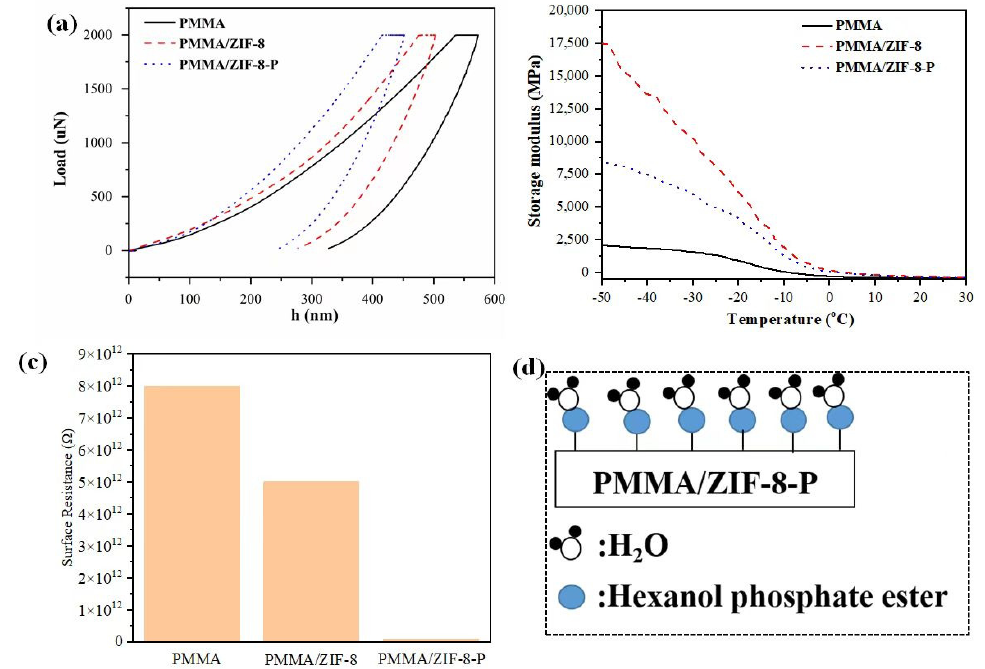
Figure 2. ( a ) The curves for load–displacement of the PMMA, PMMA/ZIF-8 and PMMA/ZIF-8-P composites. ( b ) Storage modulus gained from the DMA analysis of PMMA, PMMA/ZIF-8 and PMMA/ZIF-8-P composites. ( c ) Surface resistance of the PMMA, PMMA/ZIF-8 and PMMA/ZIF-8-P composites. ( d ) Antistatic mechanism of the PMMA/ZIF-8-P composite. Table 1. Nanoindentation results for the TGA and MCC data for the PMMA, PMMA/ZIF-8, and PMMA/ZIF-8-P composites.